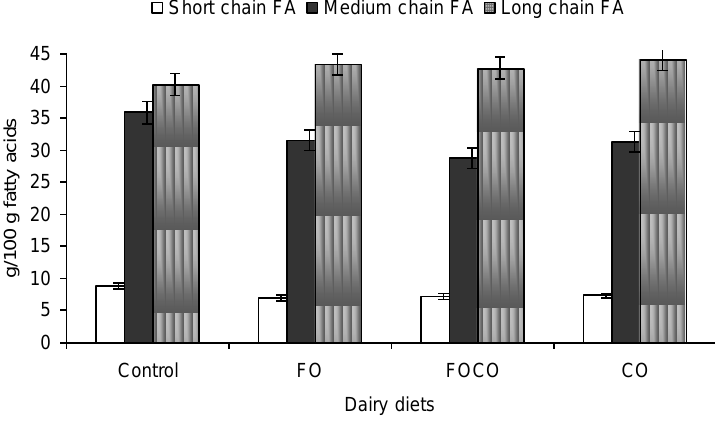
Figure 1. Proportion of short, medium and long chain fatty acids in milk fat of dairy cows fed diets containing fish (FO) and canola oil (CO). Short chain FA: C4:0-C10:0, Medium chain FA: C10:0-C16:0, Long chain FA: